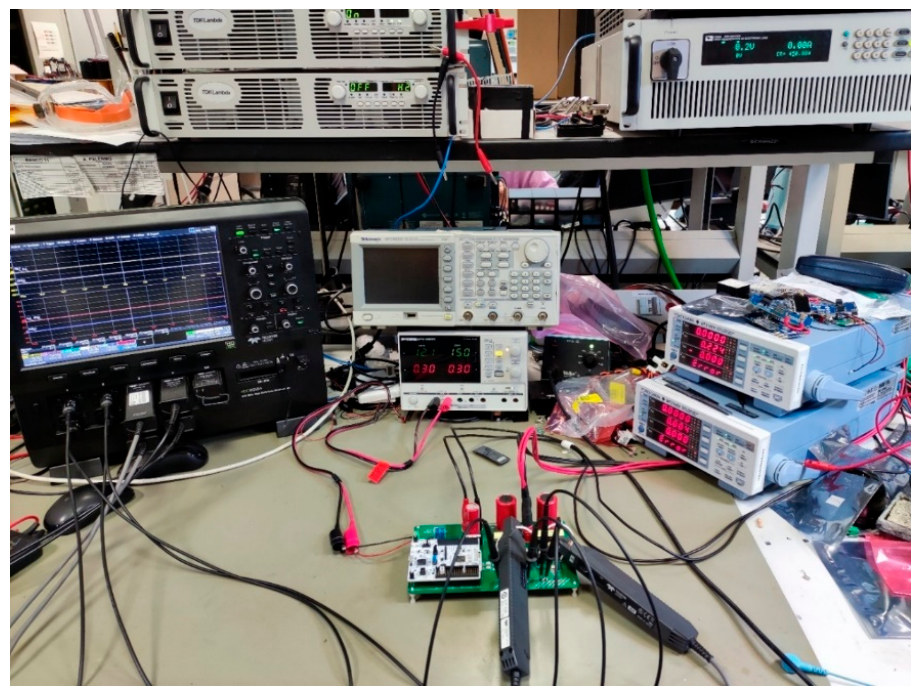
Figure 24. The experimental setup used to perform the tests.